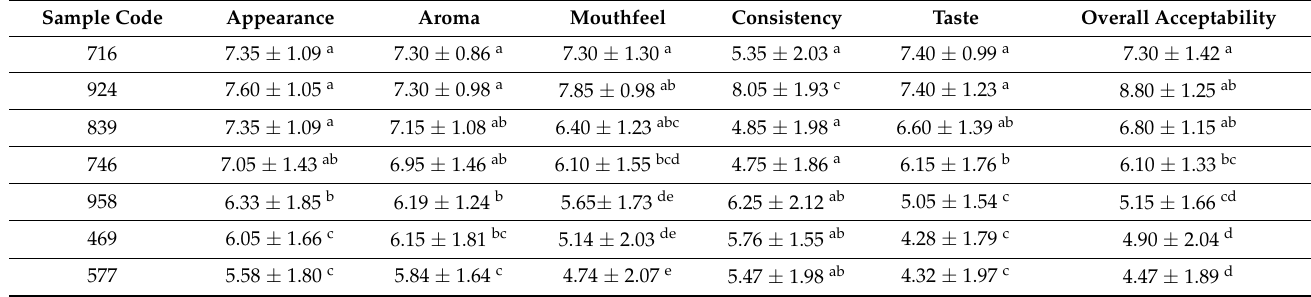
Table 5. Sensory attributes of fermented millet “ Ibyer” beverage enhanced with ginger